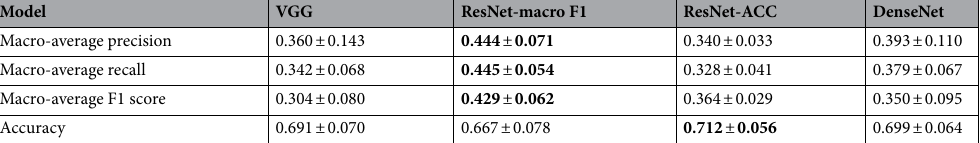
Table 3. Performance for four-class classification. Bold fonts represent the best performance among the methods. ResNet-macro F1 ResNet early stopped with macro-average F1-score, ResNet-ACC ResNet early stopped with